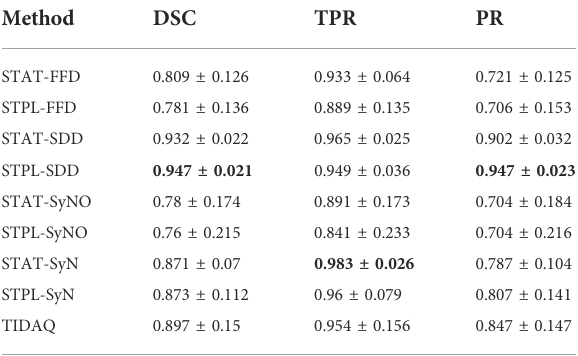
TABLE 4 38% Cortical Bone Segmentation Performance (mean ± standard deviation). DSC: Dice Similarity Coef fi cient, TPR: True Positive Rate, PR: Precision.